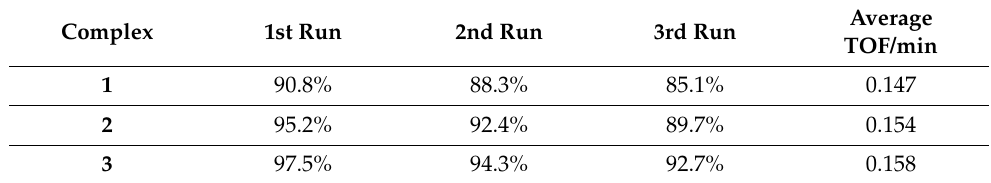
Table 5. Recyclability of catalysts in the reduction of 4-NP (1.0 mol% catalyst, % after 60 min).